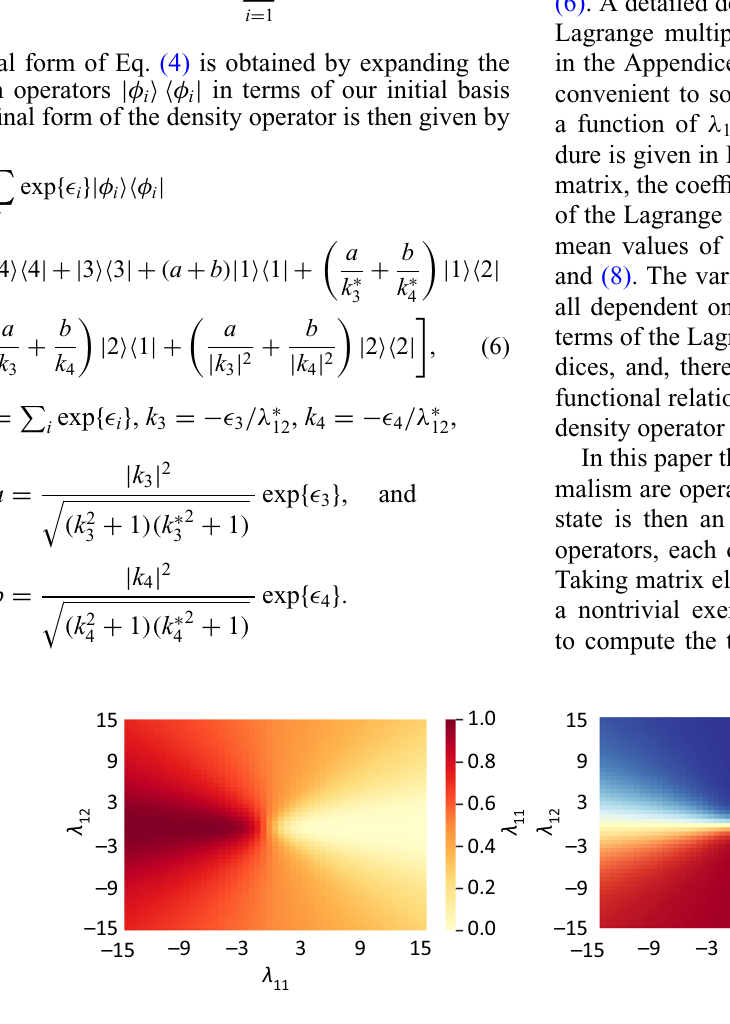
FIG. 1. Heat map representations of x 11 and x 12 as a function of λ 11 and λ 12 [keeping Im (λ 12 ) = 0]. If there are no constraints then , and there should be no finite coherence, so that x 12 = 0. This is all three quantum states should be equally probable, so that x 11 = 1 3 seen to be the case when the Lagrange multipliers are all zero. From these maps one can read the values of λ 11 and λ 12 for each given value of the